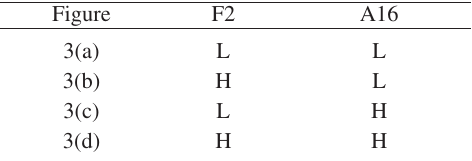
Table II. Upper and lower quartile value of F2 and